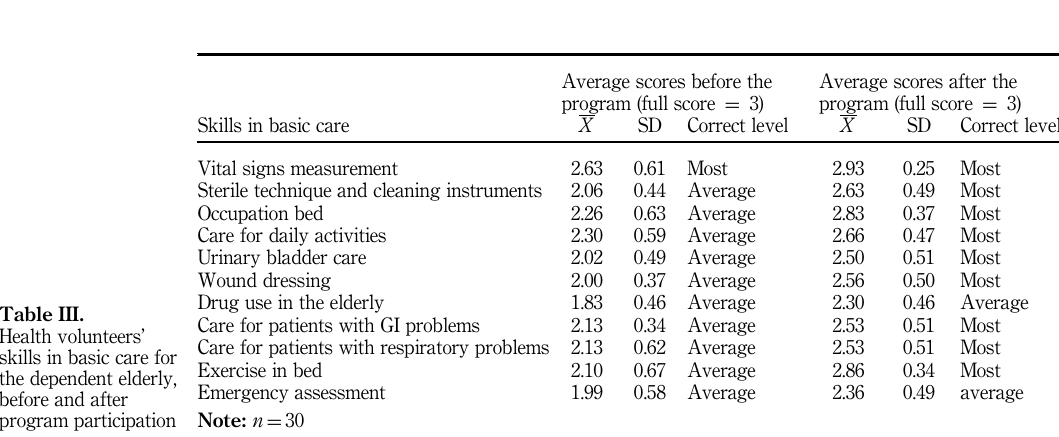
Comparison of health volunteers ’ skills in basic elderly care, before and after program